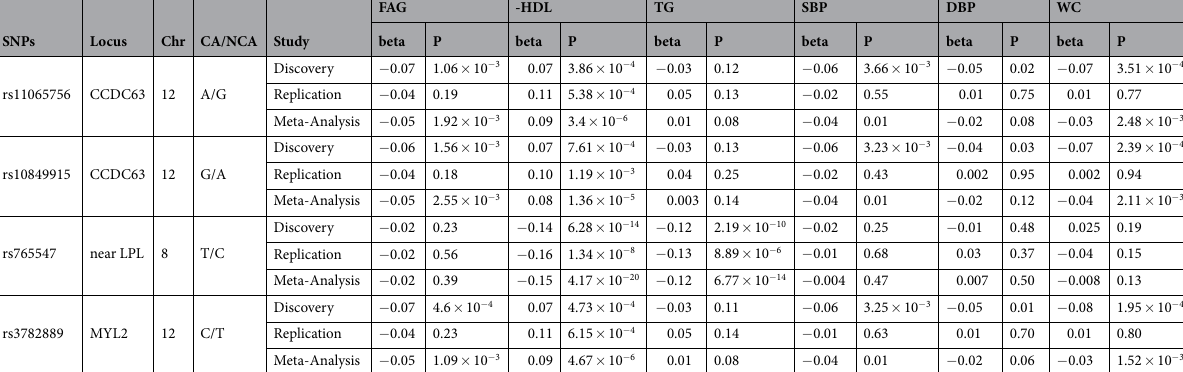
Table 2. Novel common SNPs 1) of metabolic syndrome for its six traits achieving genome-wide significance in Korean population. 1) SNPs not previously reported in GWAS of MetS traits. Chr, chromosome; CA, coded allele; NCA, noncoded allele; P, P for multivariate analysis; FAG, fast glucose; TG, triglyceride; WC, waist